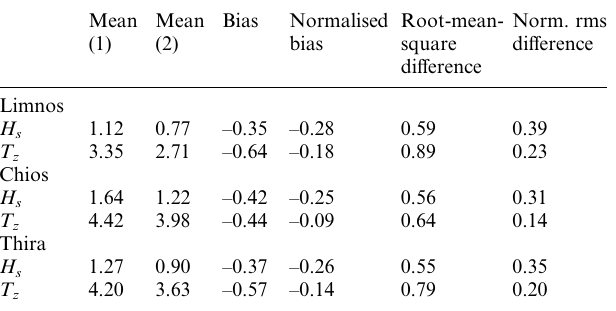
Table 5. Statistics for the storm August 1990, -40 points. Comparison of results from WAM model using UKMO and ECMWF winds